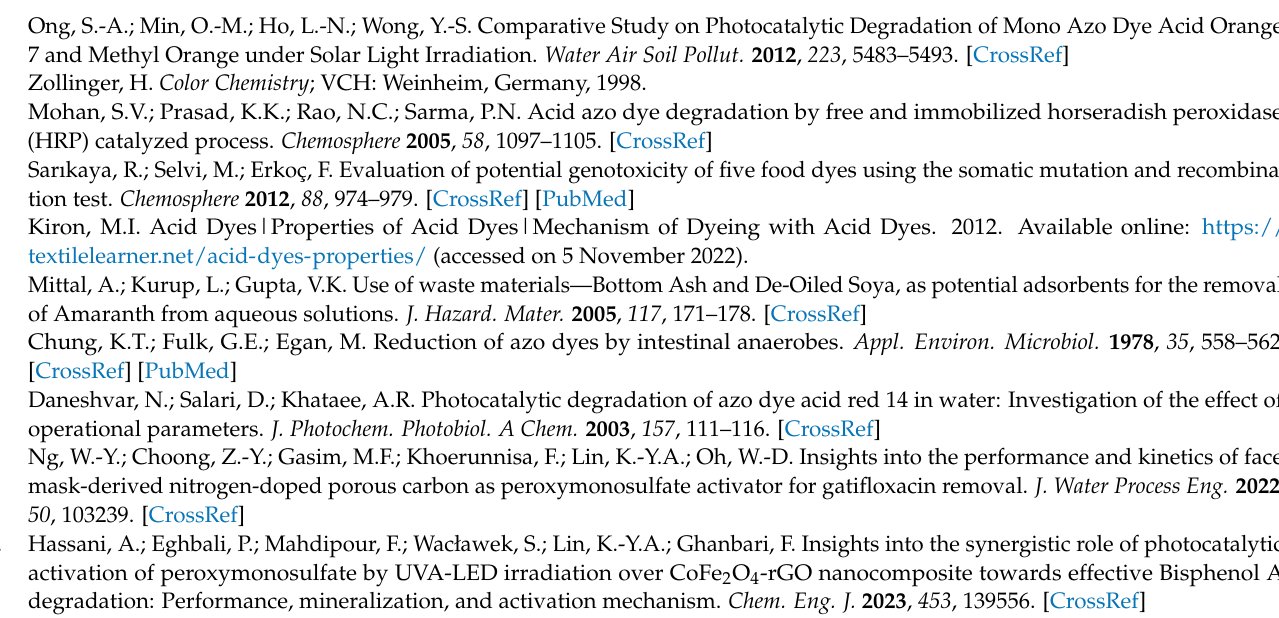
Table S1. A comparison of E a values for AR degradation by Oxone activated by various catalysts. Table S2. Detected by-products of AR degradation by FCCM+Oxone; Figure S1. SEM images of the pristine Cu mesh under different magnifications; Figure S2. Simulated XRD patterns of CuO, Cu 2 O and CuCo 2 O 4 . Figure S3. Removal of AR through adsorption to those catalysts (Catalyst = NP. Figure S5. CV curves of (a) CuOM, (b) NCCM, (c) SCCM, and (d) FCCM at different scan rates. Figure S6. Species of Oxone at various pH; Figure S7. ESI mass spectrum of intermediates of AR